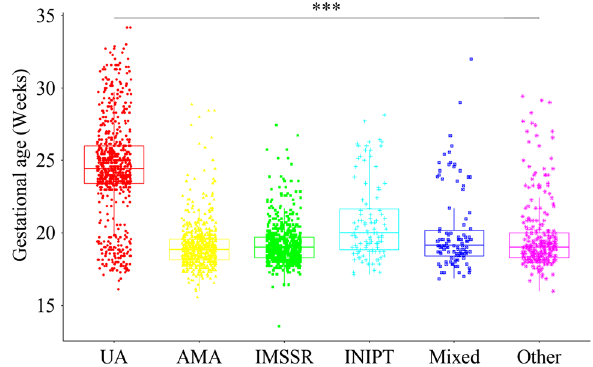
Figure 2. The gestational weeks of pregnancies with different indications. UA, ultrasound abnormalities; AMA, advanced maternal age; IMSSR, increased maternal serum screening risk; INIPTR, increased NIPT risk. Other indications included previous fetus/child with genetic or phenotypic abnormalities, carriers of monogenic genetic diseases, medication during pregnancy, embryos stopping developing, and intellectual disability of pregnant women. ***Represented a P <